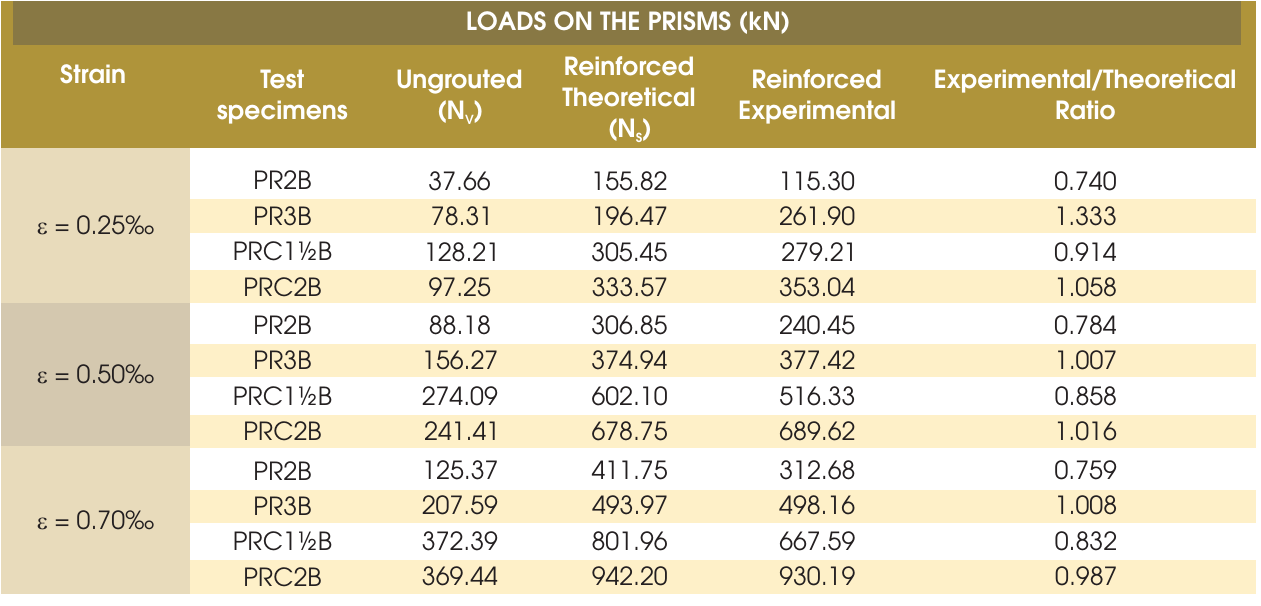
Table 11 – Comparison of mean theoretical and experimental loads for some strains (Model III –